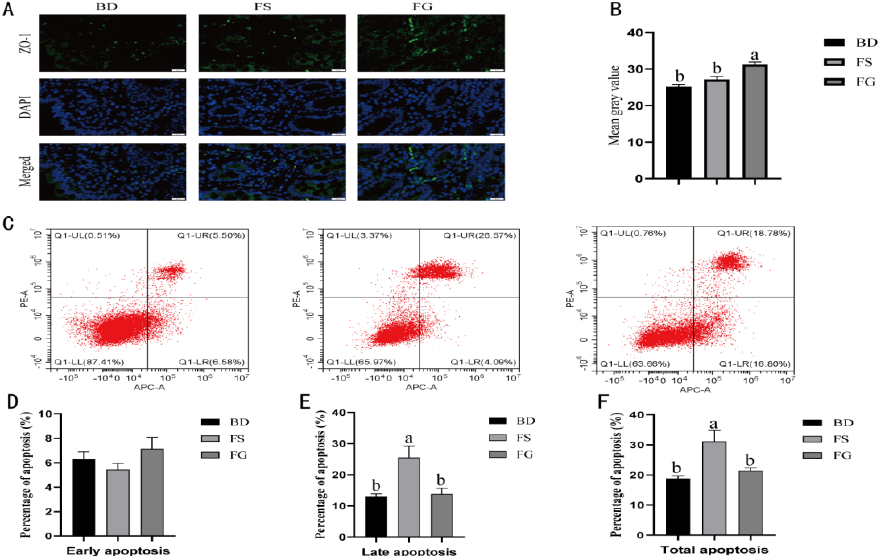
Figure 2. Effect of SPIC on ZO-1 distribution and apoptosis of the intestinal epithelium cells. ( A ) Localization of ZO-1 and DAPI (DNA) in the jejunum. ZO-1 protein (green), DAPI stain (blue), as well as merged ZO-1 protein and DAPI, are presented; ( B ) the mean gray value of ZO-1; ( C ) the result of jejunal cell apoptosis by flow cytometry in weaned piglets. A total of 30,000 cells were used in each acquisition reading. Frames were divided into 4 quadrants: Q1-UL represents necrotic cells; Q1-UR represents late apoptotic and early necrotic cells; Q1-LR represents early apoptotic cells; and Q1-LL represents normal cells; percentages of apoptotic cells of early apoptosis ( D ), late apoptosis ( E ), total apoptosis ( F ) in the jejunum, respectively. a,b,c Mean values with different letters on vertical bars indicate significant differences ( p < 0.05). BD, basal diet with no iron supplementation; FS, basal diet with FeSO 4 (containing 100 mg Fe/kg) supplementation; FG, basal diet with Fe-Gly (containing 100 mg Fe/kg) supplementation.